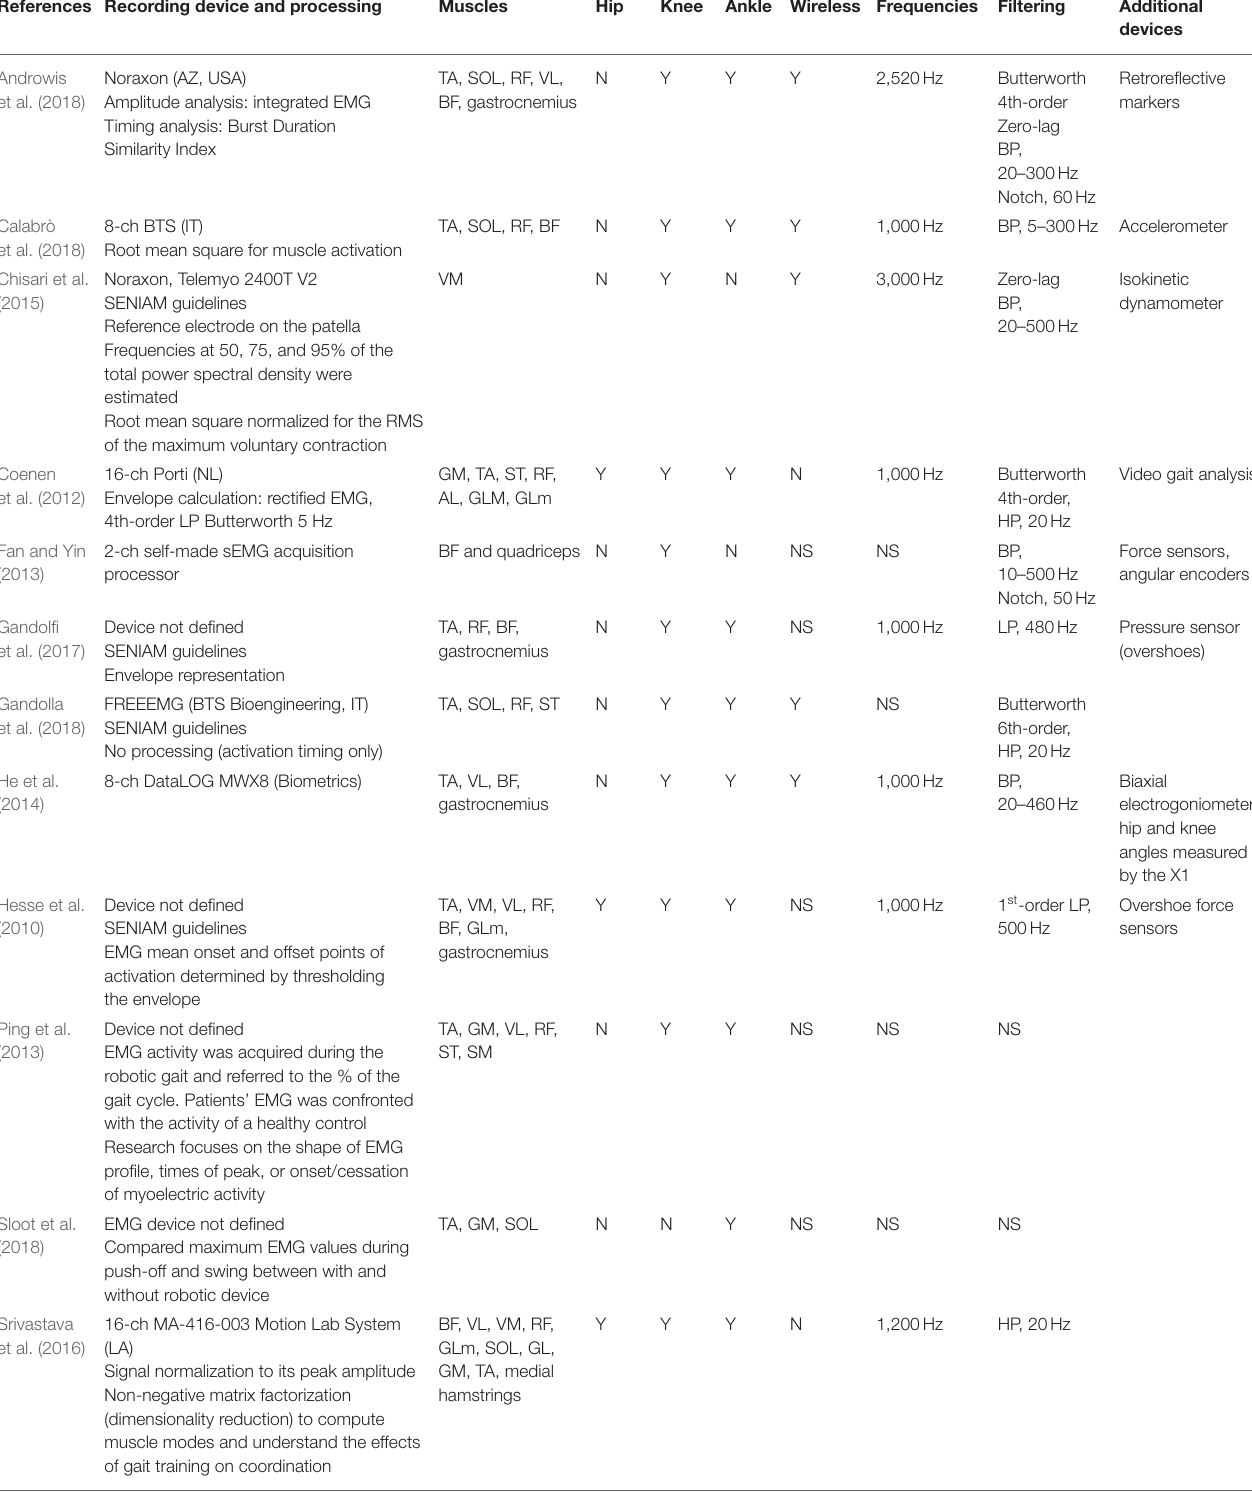
TABLE 4 | Electromyography (EMG) signal processing in included